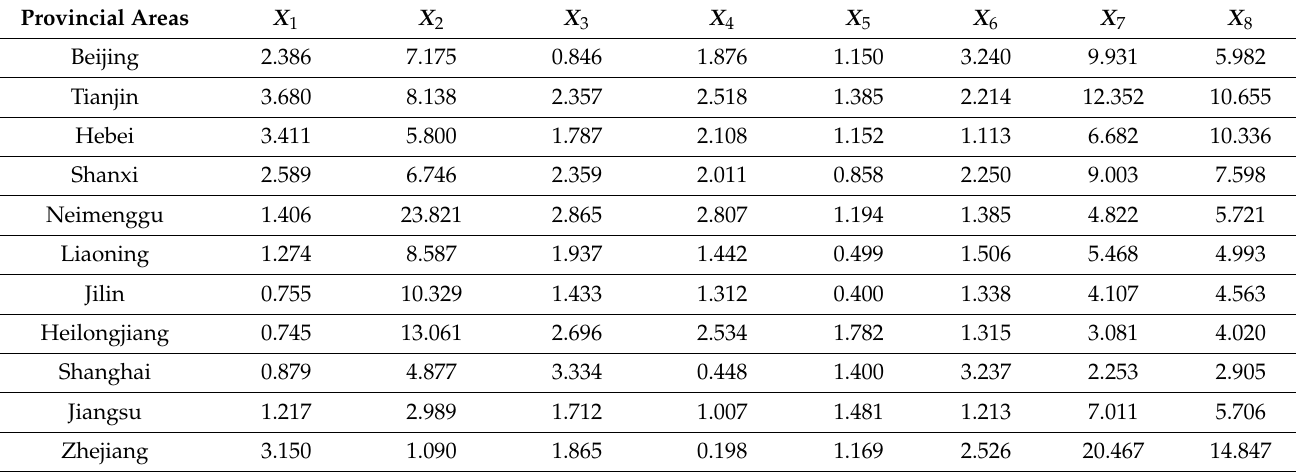
Table 2. Data of 31 provincial areas in